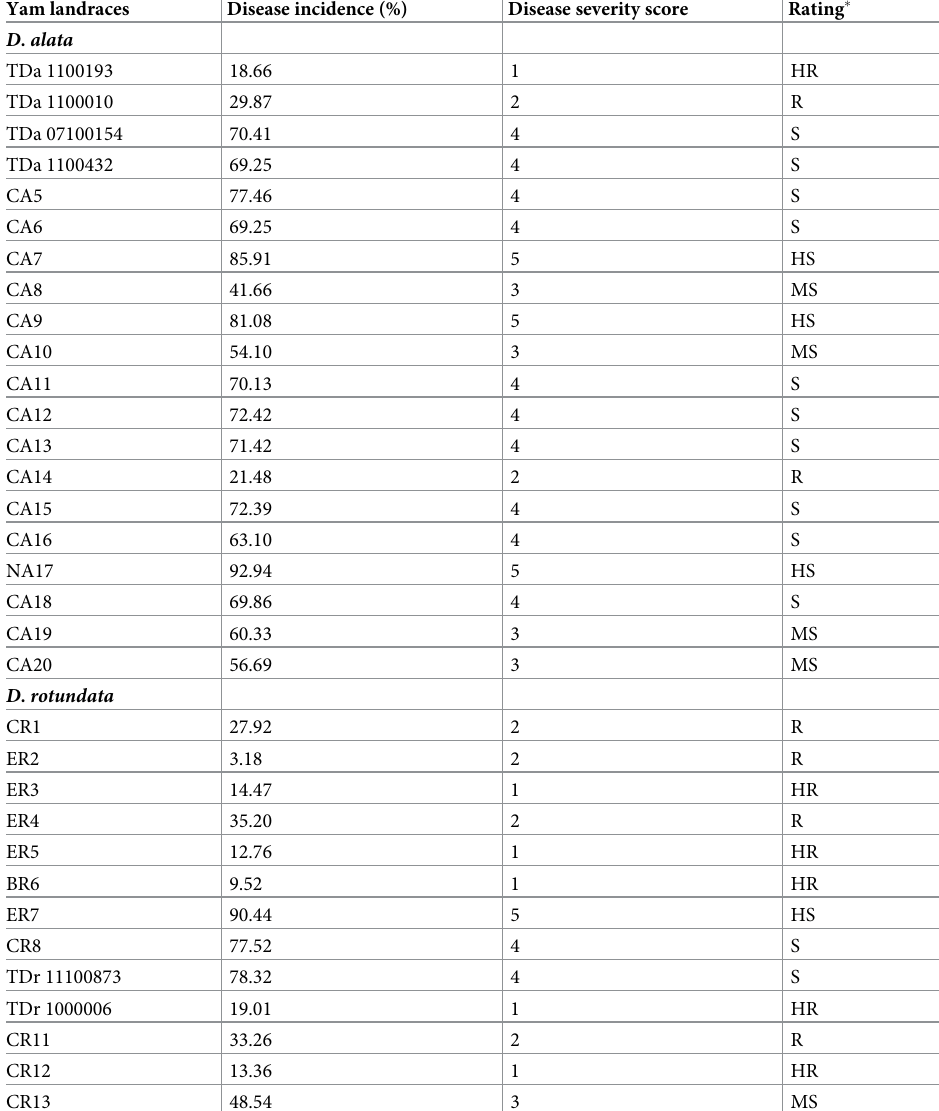
Table 4. Disease incidence, disease severity score and resistance status in Dioscorea alata and Dioscorea rotundata landraces screened for anthracnose resistance. Yam landraces Disease incidence (%) Disease severity